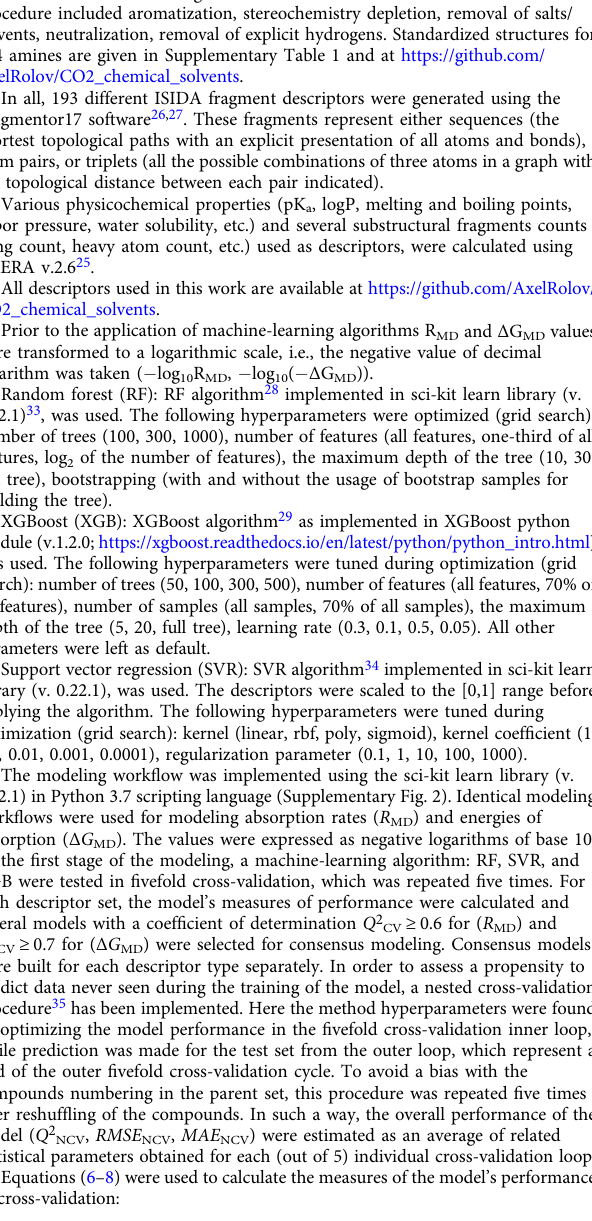
water. Standard deviations of the values are shown as error